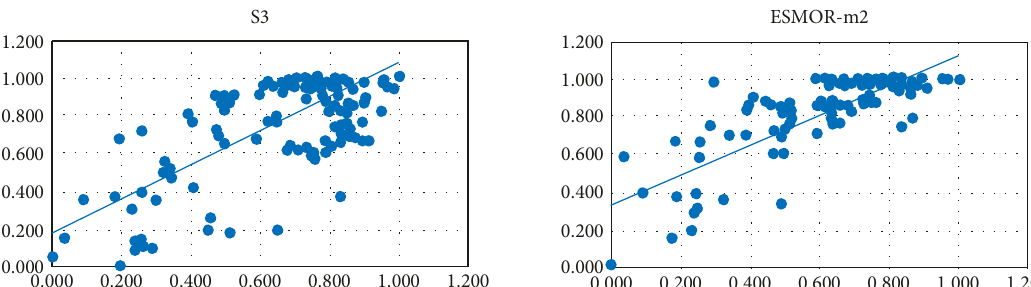
Figure 5: Shows the neural network trained according to the input of 1000 groups of sun running data and output of 1000 groups of endurance results. When randomly inputting 100 groups of students’ long-distance running data that has been trained, the BP neural network predicts the relationship between endurance results and actual values. It can be seen from the figure that the prediction accuracy of most points is high, except for some abnormal points.